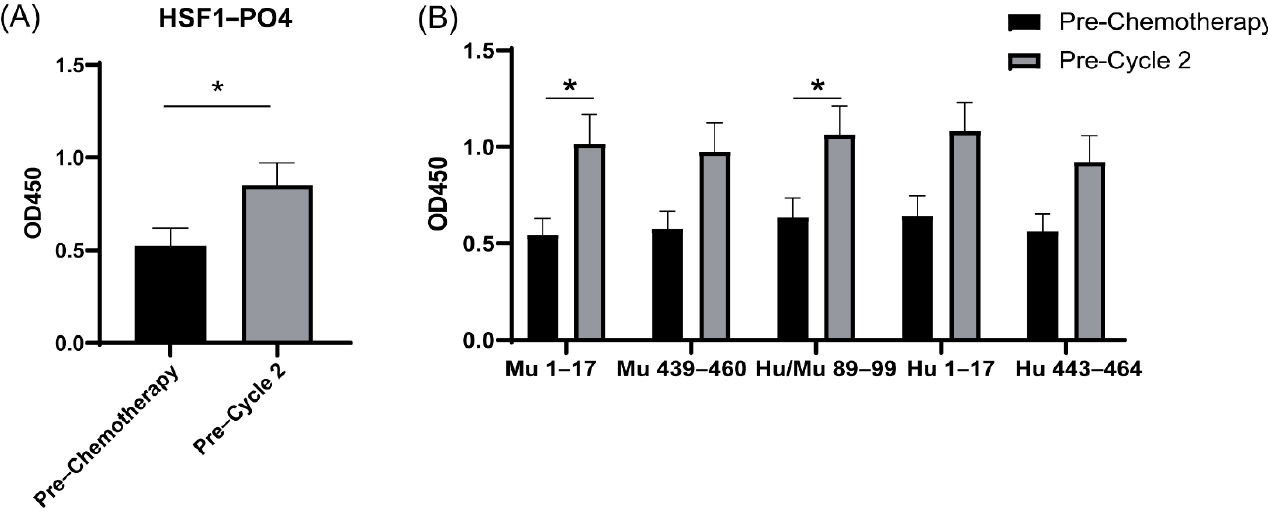
Figure 7. IgA-specific antibody responses in patients at diagnosis and prior to cycle 2 of first-line chemotherapy ( n = 10). Sera (diluted 1:10) IgA responses against ( A ) HSF1-PO4 or ( B ) predicted epitopes. Data are shown as the mean ± SEM from duplicates. A paired T-test was performed, * p < 0.05.